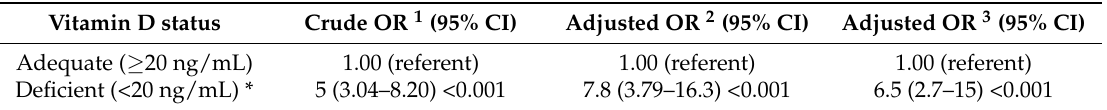
Table 3. Odd ratios (95% confidence interval) for CHD among subjects with Vitamin D deficiency in adults in Saudi